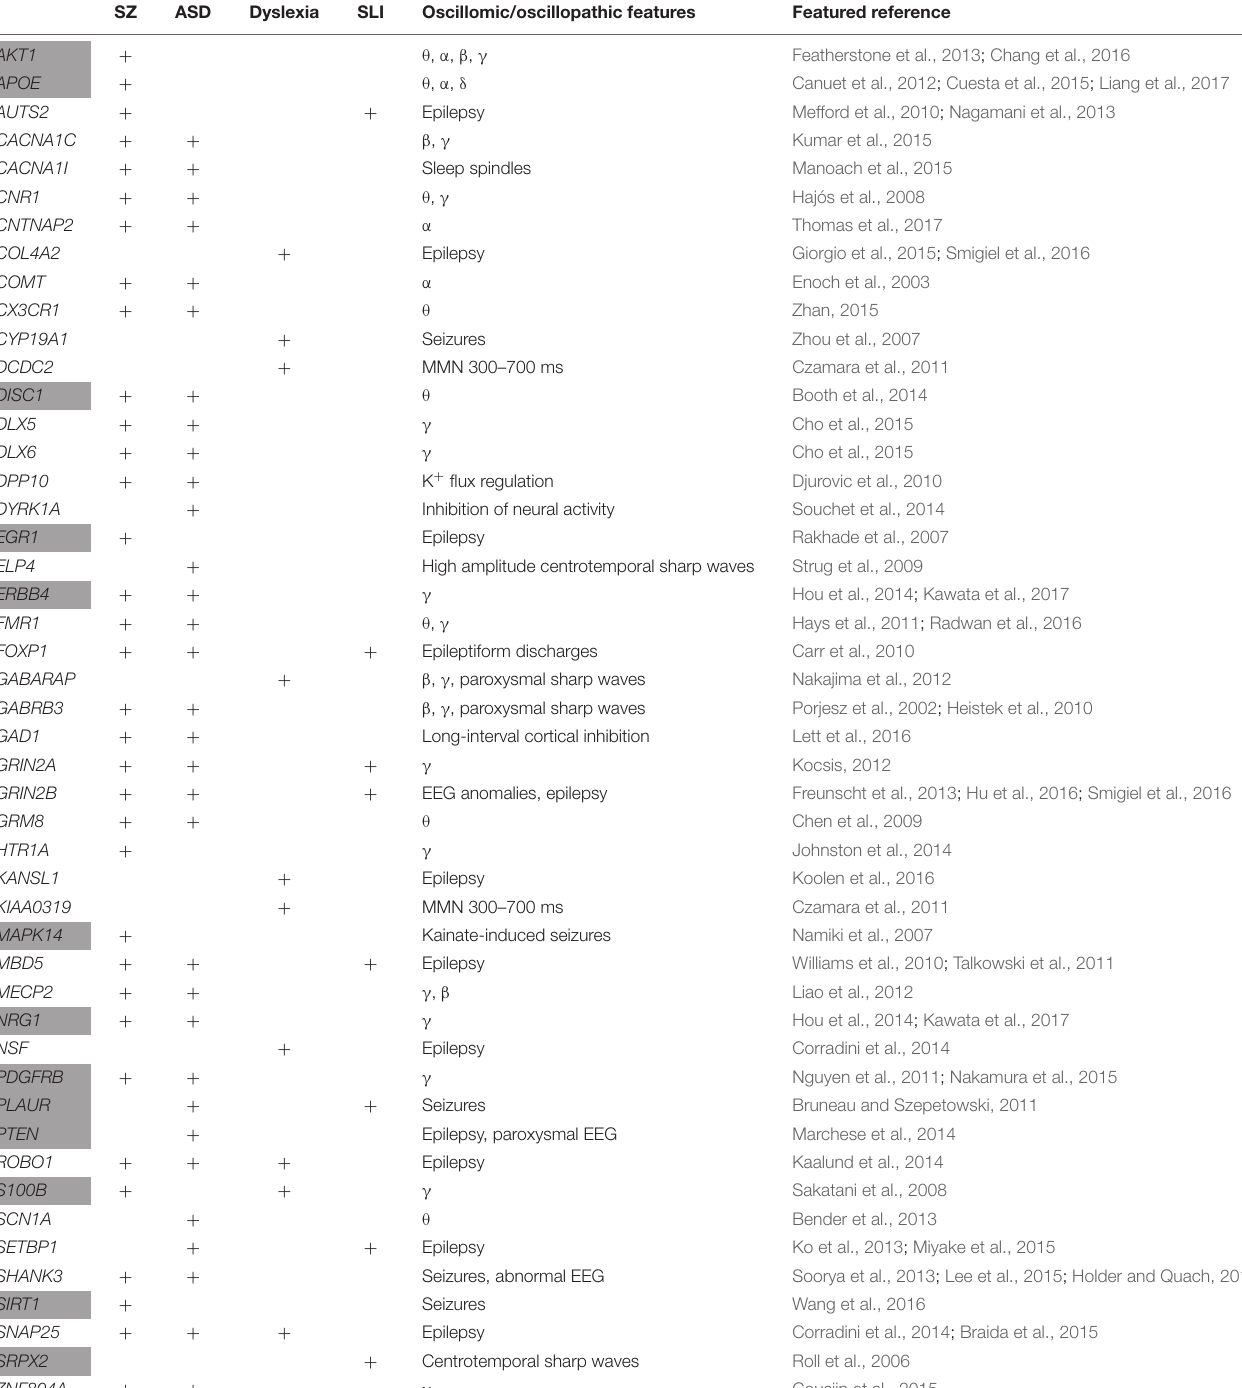
TABLE 1 | The set of candidates comprising the language oscillogenome. SZ Dyslexia